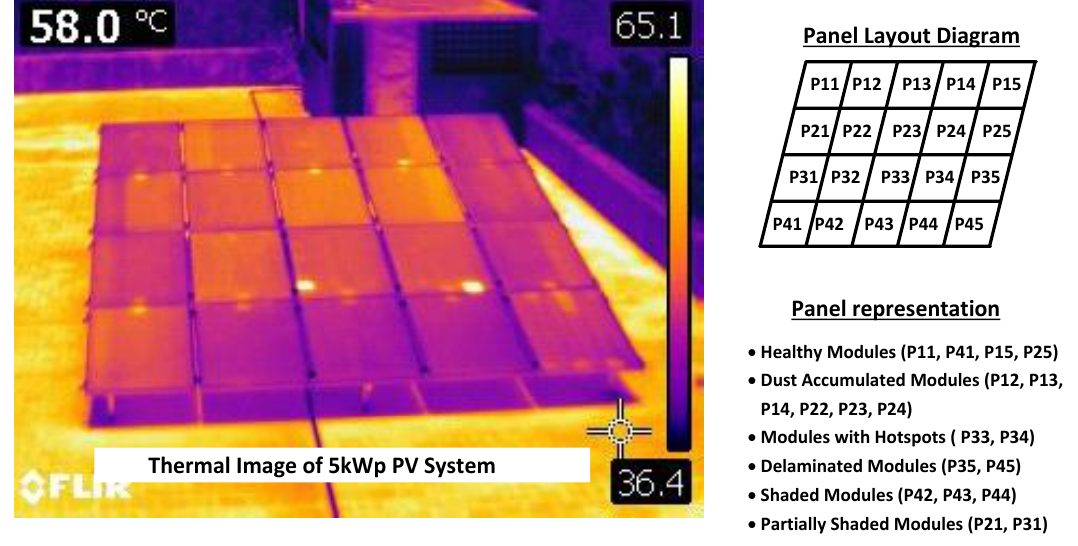
Figure 14. Thermal Image of 5 kW PV System with Various Defects.